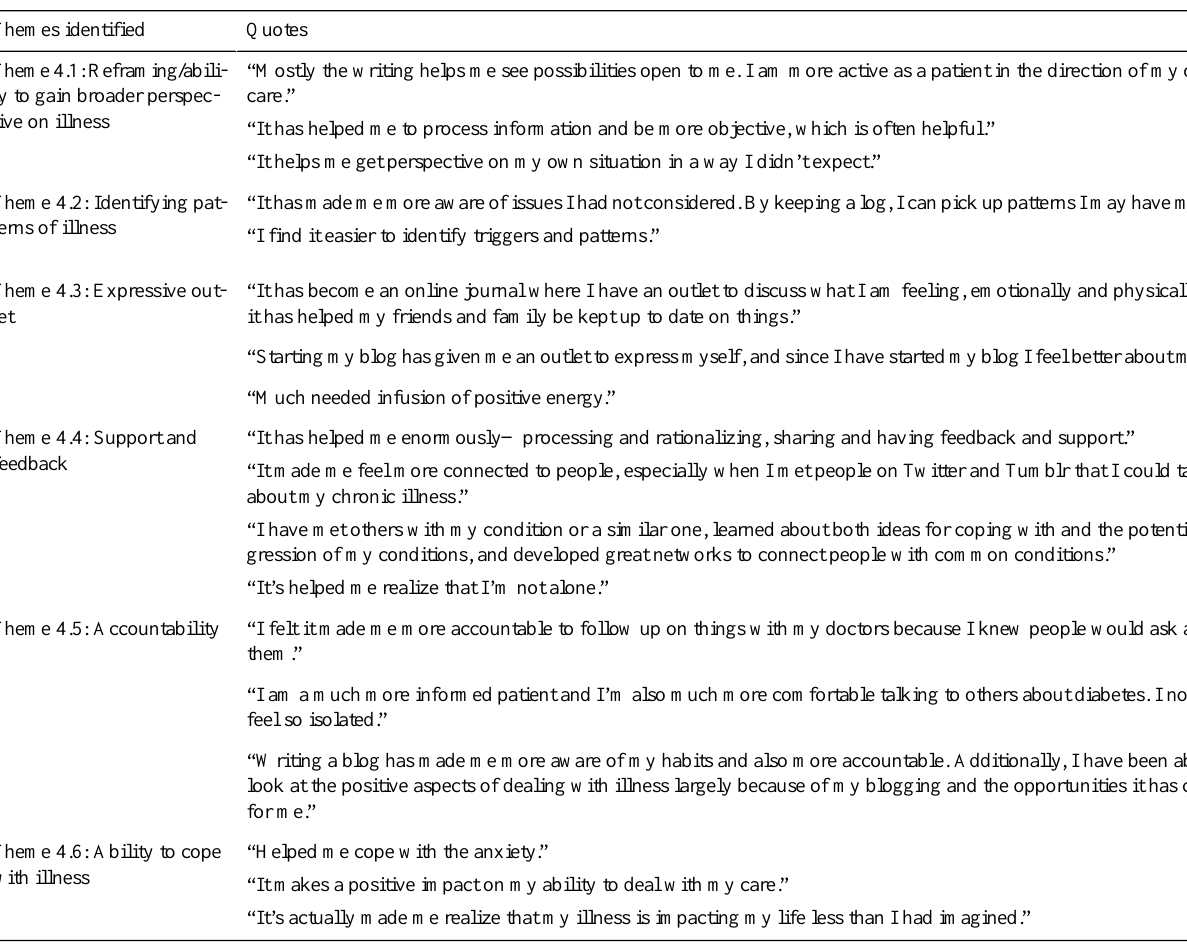
Table 6. Did blogging change how one deals with the challenges of chronic illness or pain?